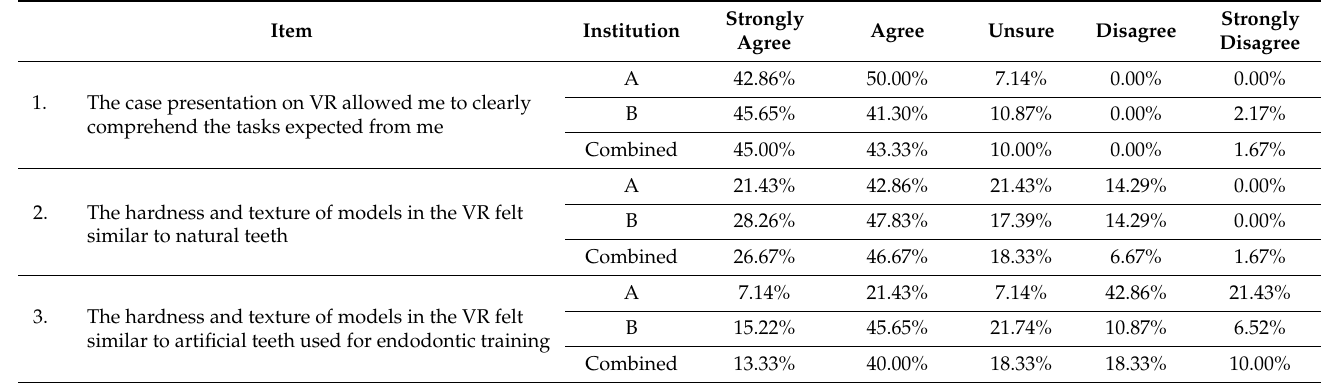
Table 1. Participants’ responses on pre-clinical training in